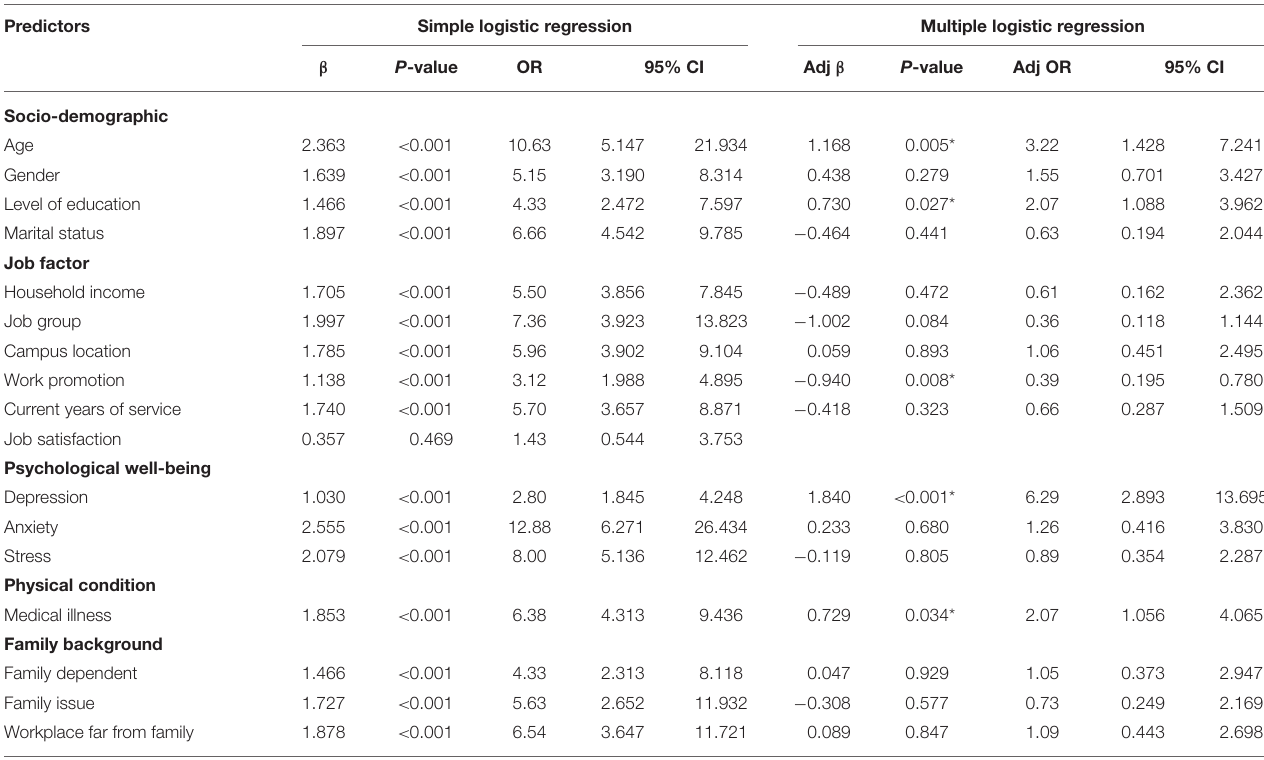
TABLE 5 | Logistic regression analyses for the predictors of WHOQOL-BREF E-QOL domain. Predictors Simple logistic